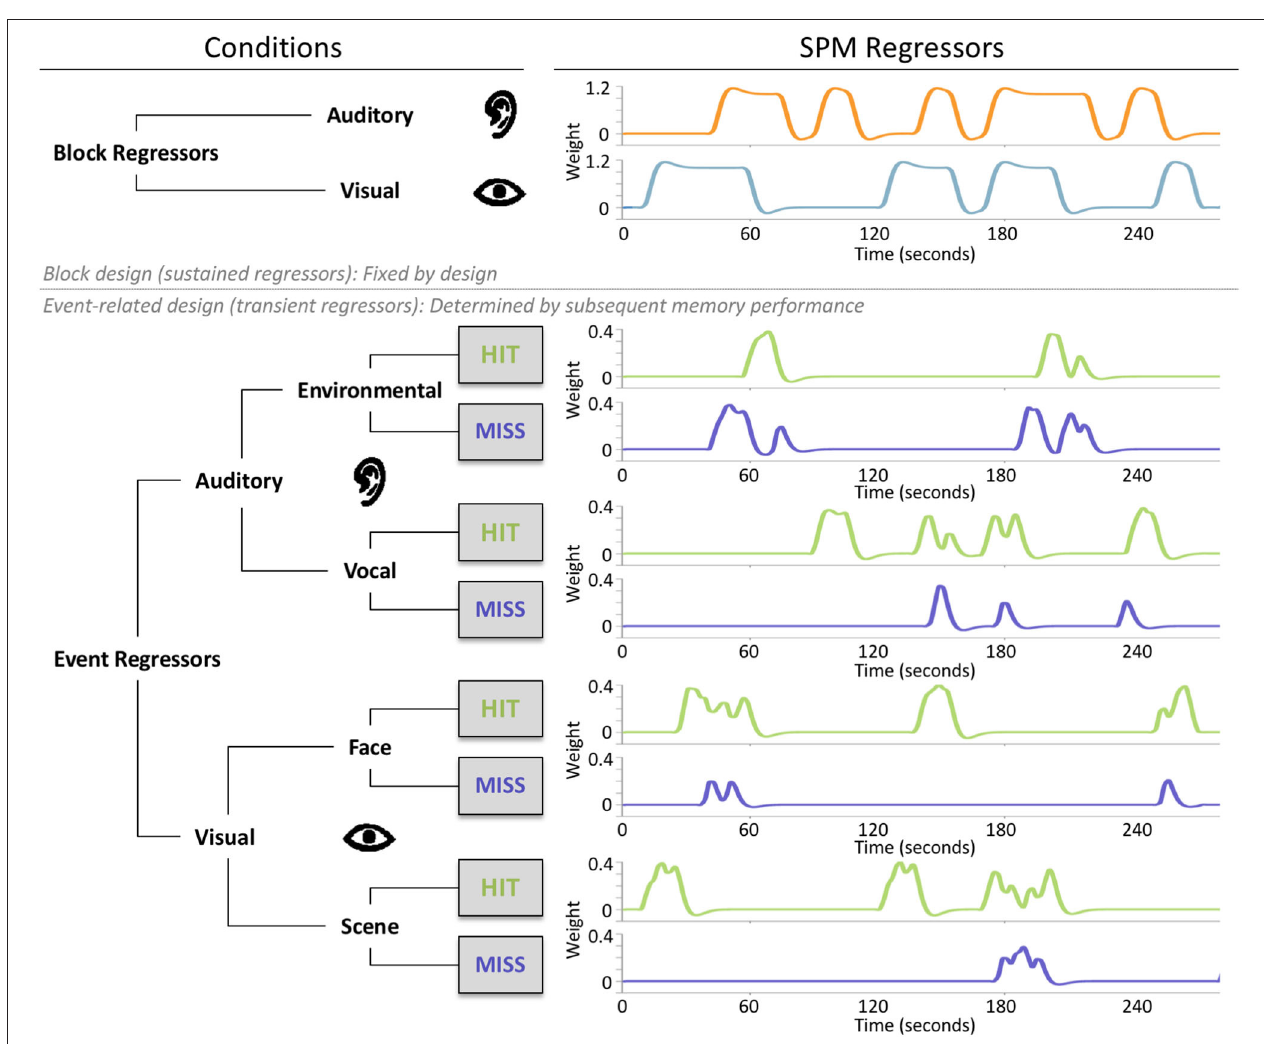
FIGURE 2 | The parallel mixed design consisted of two fixed block regressors, one for the auditory and one for the visual blocks, and eight subject-specific event regressors. These event-related regressors were determined by the combination of stimulus types, auditory (environmental/vocal) or visual (face/scene) and subsequent memory performance (hits/misses). Event regressors represent the SPM regressors of a single exemplary